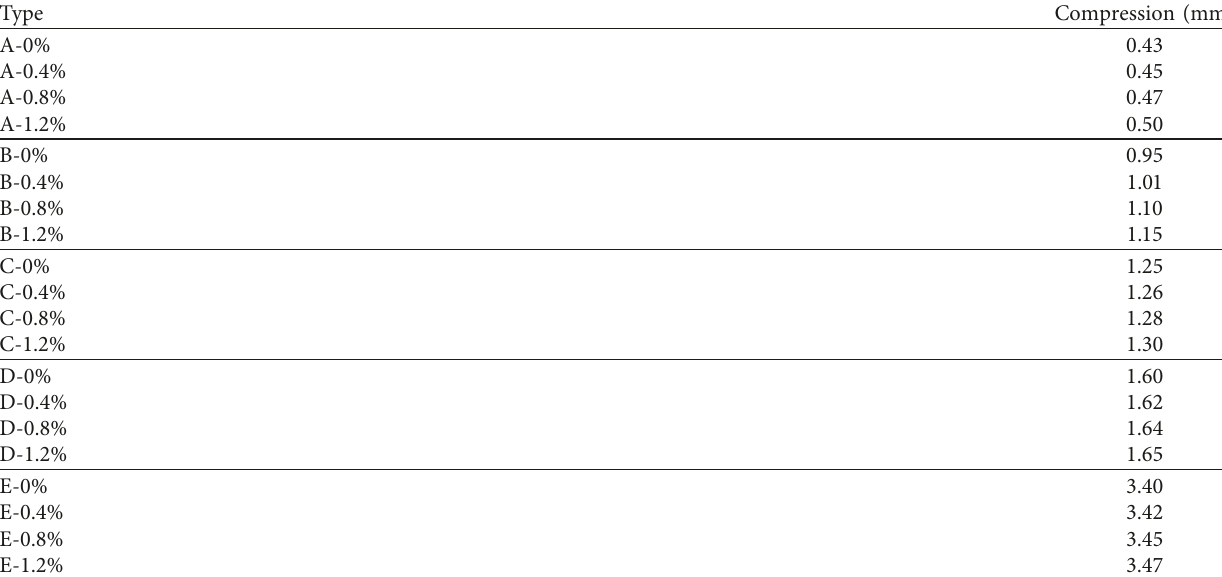
Table 4: Compression of BF-CRM with different proportions.